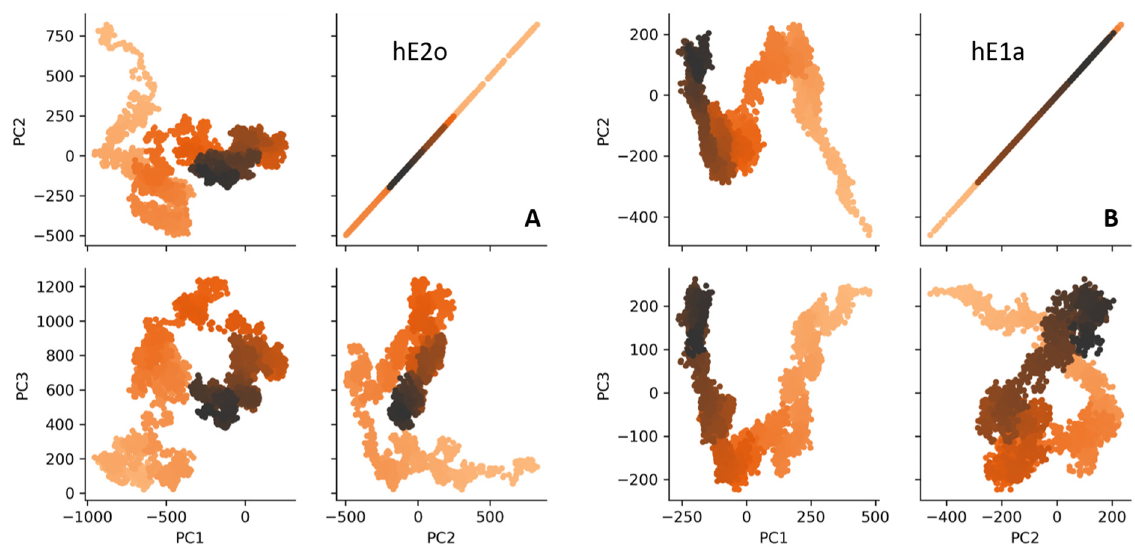
Figure 5. PCA projections of the first three principal components for the hE2o ( A ) and hE1a ( B ) trajectories. The color scale is according to the simulation time, with deeper oranges belonging to more advanced time points. Conformational changes could be followed in time for all the components of the system.